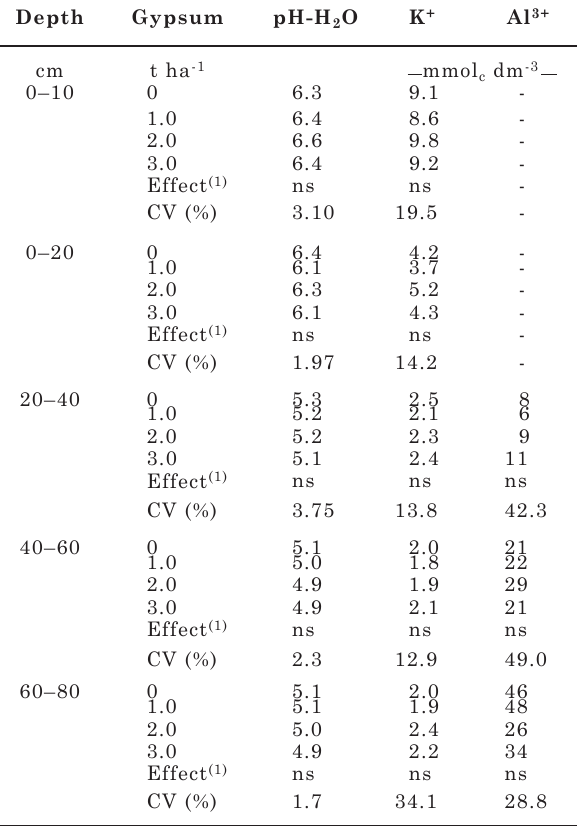
table 2. Soil pH and exchangeable values of K and al at different soil depths after broadcasting